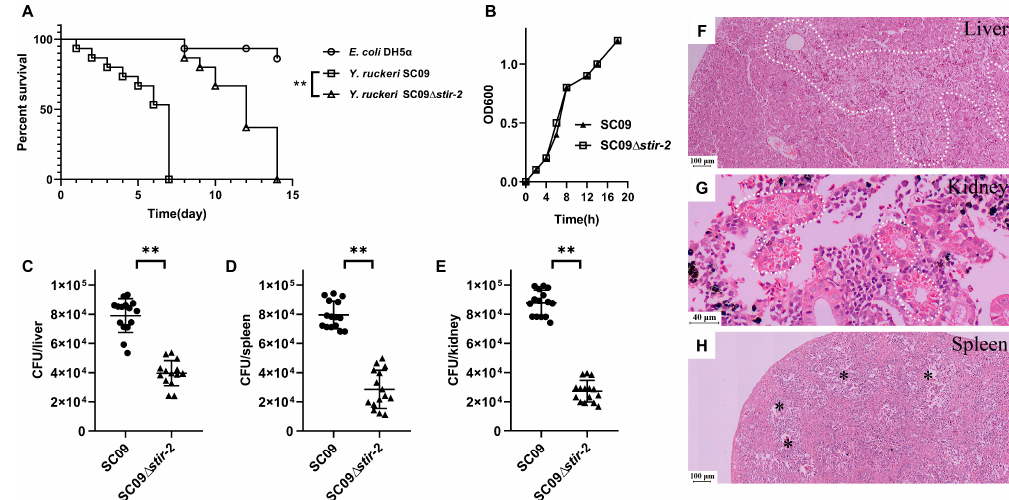
Figure 2. STIR-2 is required for Yersinia ruckeri SC09 infection in vivo. ( A ) Rainbow trout survival curve. Rainbow trout were infected with either wild-type Y. ruckeri SC09 or SC09 ∆ stir-2 . The Mantel-Cox test was used with ** p < 0.01. Fish infected with E. coli DH5 α , which has low toxicity to fish, acted as a negative control. ( B ) Growth curve of wild-type Y. ruckeri SC09 and SC09 ∆ stir-2 . ( C – E ) Rainbow trout were infected with either Y. ruckeri SC09 or SC09 ∆ stir-2 ( n = 15 / group). Bacterial load in the liver ( C ), spleen ( D ), and kidney ( E ) was assessed in cultured the tissue homogenates. A non-parametric two-tailed t -test was carried out with ( C ) ** p < 0.01, ( D ) ** p < 0.01, and ( E ) ** p < 0.01. ( F – H ) Pathological lesions of rainbow trout infected with wild-type Y. ruckeri SC09. Necrotic areas in the liver ( F , white dotted line); glass-like substrate in kidney tubules ( G , white dotted line); edema in spleen medulla ( H , asterisk)